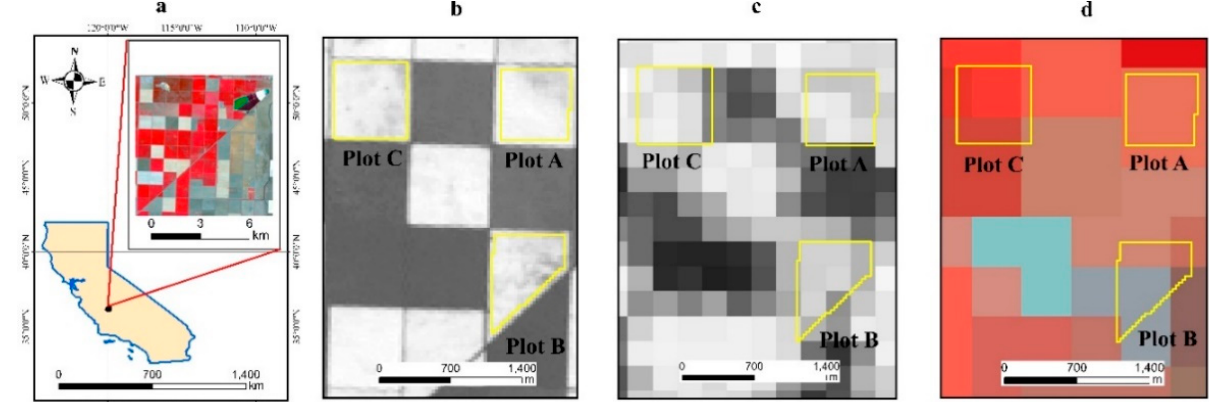
Figure 1. Map of the study area; ( a ) California map and Landsat 30 m image of the study area on DOY 206; ( b ) study plots overlain on Landsat NDVI on DOY 206; ( c ) study plots overlain on MOD13Q1 250 m (MODIS NDVI) image on DOY 193; ( d ) study plots overlain on MOD09GA 500 m image (Band 2, band 1, band 4) on DOY 206.